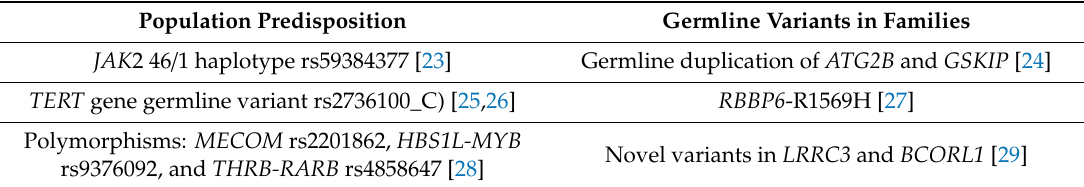
Table 1. Genetic predispositions associated with familial myeloproliferative neoplasms in population and individual families Population Predisposition Germline Variants in